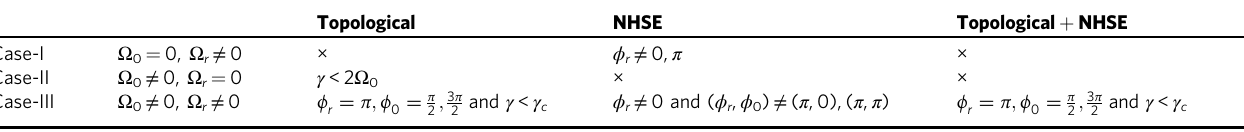
Table 1 Conditions for achieving topological phase and non-Hermitian skin effect (NHSE) for various cases. Topological NHSE Topological + NHSE Case-I